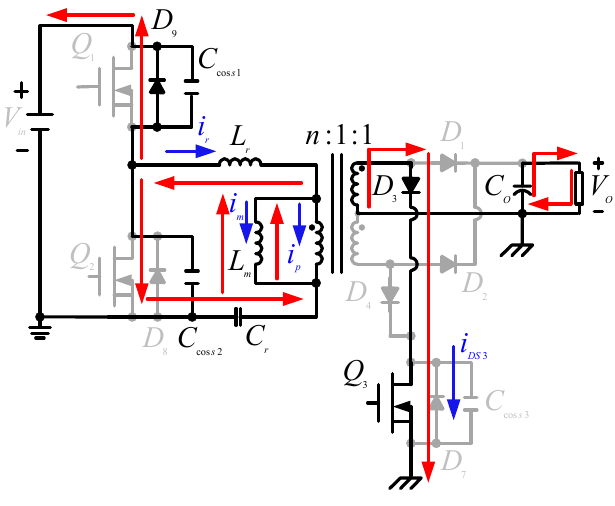
Figure 14. Working State 1 of novel LLC control circuit.